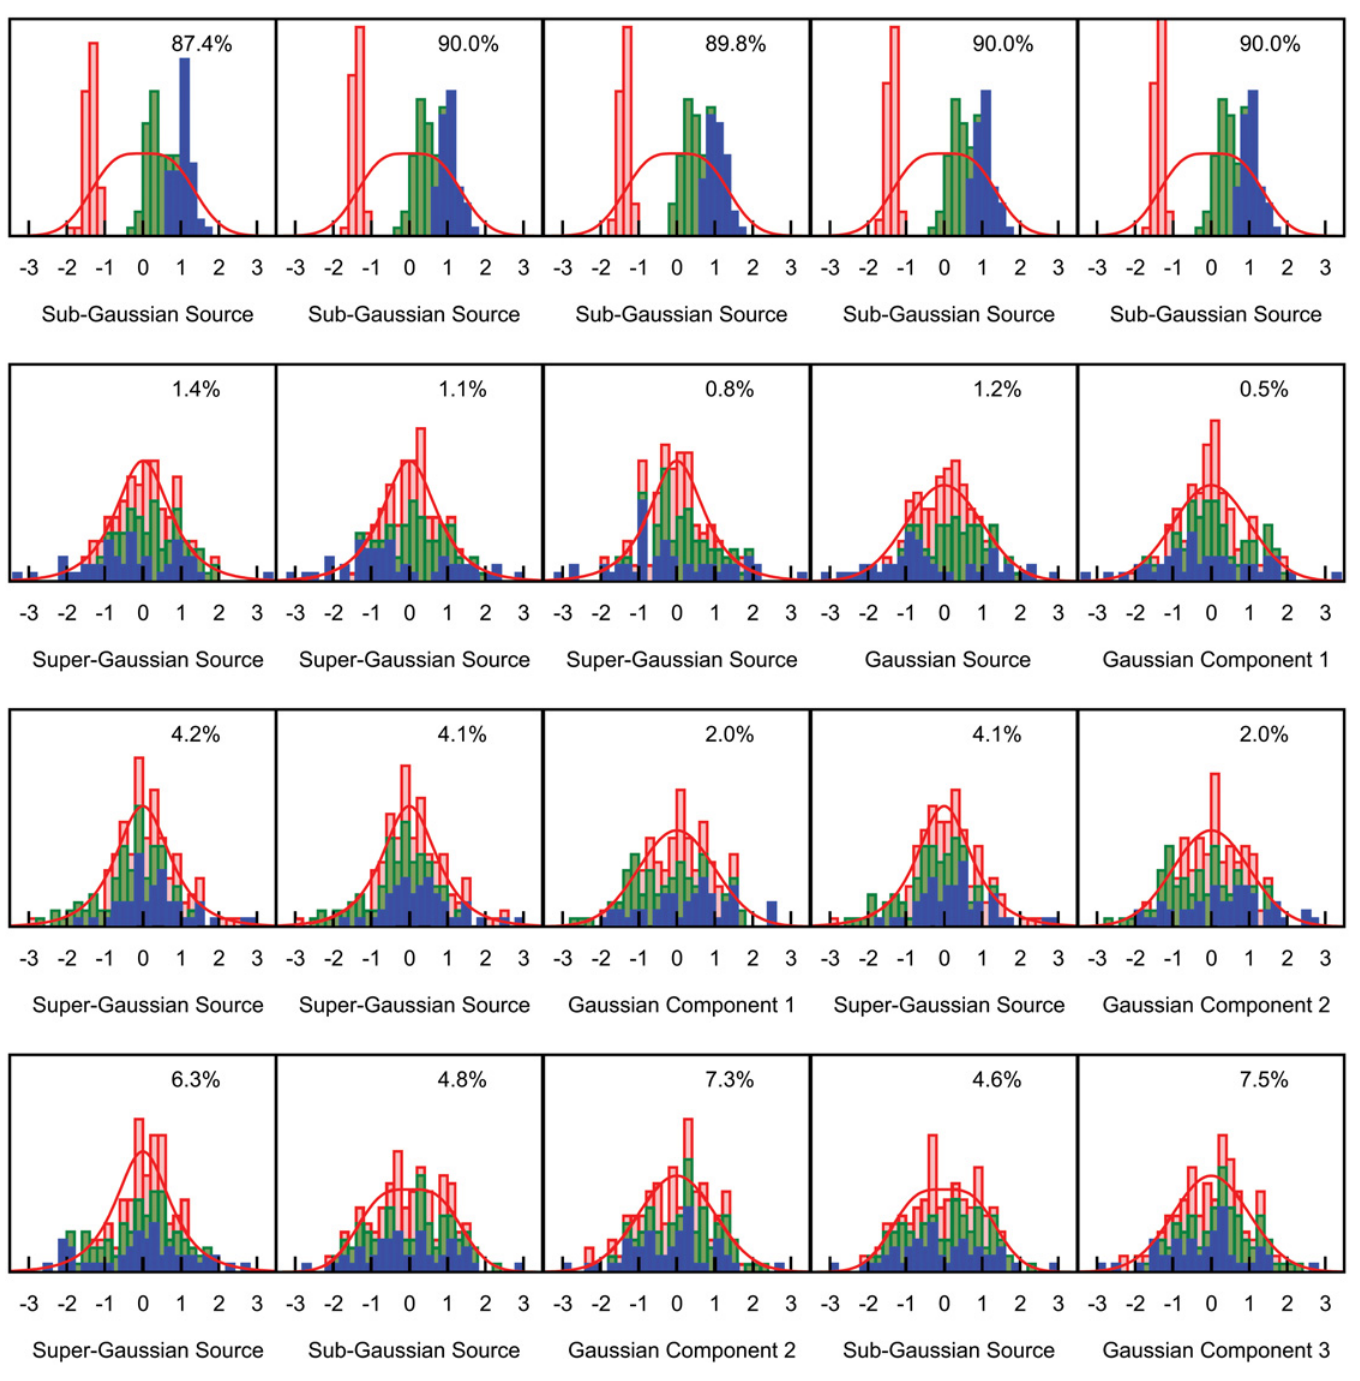
Fig 4. Distributional results for the five best model categories for the iris dataset. Histograms of sources for the best fitting model in each of the five best ^ T with the corresponding model source distribution superimposed. Each species is shown in a model categories are shown in columns in order of n n (cid:4) 1 n (cid:4) 1 different color, I setosa in red, I versicolor in green and I virginica in blue. Histograms have been displaced vertically when necessary to prevent members of one species from obscuring those of another species. The non-Gaussian sources from each model have been sorted such that the most strongly correlated sources from the different models appear in the same row. The percentage values reflect the contribution of each source to the total variance.